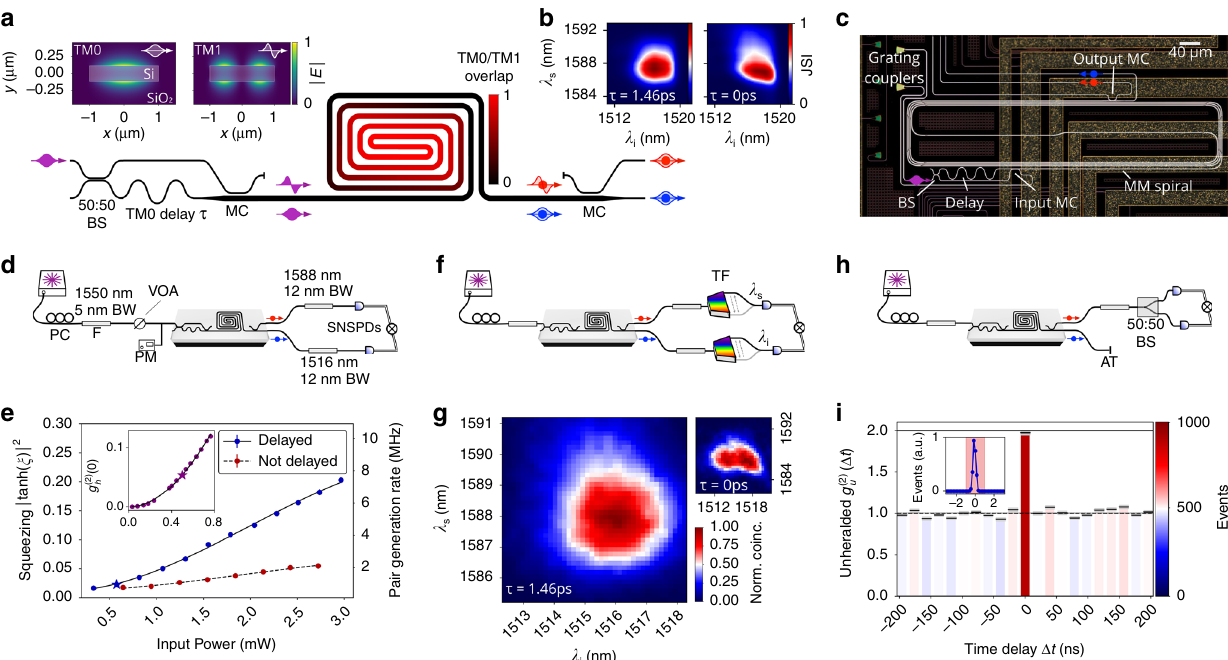
Fig. 1 Design and performance of the multi-modal source. a Schematic of the source. An input near-1550 nm pulsed pump laser (4.5 nm bandwidth), initially propagating in the TM0 mode, is split using a 50:50 beam-splitter (BS). The output in the upper arm of the BS is converted into the TM1 mode via a mode-converter (MC), while the TM0 output in the lower arm is delayed by a time τ = 1.46 ps. Due to the different group velocities, the two modes become overlapped and subsequently diverge again while propagating through the source, as qualitatively colour-coded in the fi gure. Photon pairs, with the signal photon (near 1588 nm) in the TM1 mode and the idler photon (near 1516 nm) in the TM0 mode, are emitted via inter-modal SFWM and fi nally deterministically separated via a MC. Inset: cross sections of the TM0 and TM1 modes in the MM waveguide. b Simulated JSI of the source in the presence of a delay τ = 1.46 ps (left) and with no delay (right), with corresponding single photon purities of 99.4% and 84.0%. c Optical microscope image of a single multi-modal source structure-waveguides are highlighted. d Set-up to characterise squeezed light via second-order correlation measurements, using a polarisation controller (PC), fi bre pass-band fi lter (F), variable optical attenuator (VOA), and an optical power monitor (PM). e Measured squeezing as a function of (off-chip) pump power. Blue and red points are data measured in a source with and without delay, respectively, with a fi t shown as a black ð 0 Þ as a function of input powers. f Set-up for the characterisation of line. The stars indicate the typical operating regime. Inset: measured heralded g ð 2 Þ h the emitted JSI, using a tunable fi lter (TF). g Measured JSI from the source with delay (left) and without delay (right), with respective corresponding spectral purities of 0.9904(6) and 0.931(2). h Set-up for purity characterisation via unheralded second-order correlation measurements. Idler photons are ð Δ t Þ in the source with delay. Each bar corresponds to a coincidence window of discarded via an absorbing termination (AT). i Measured unheralded g ð 2 Þ u ð 0 Þ ¼ 1 : 97 ð 3 Þ corresponds to a photon spectral purity of 0.97(3). Error bars represent 1 s.d. and are calculated assuming 2 ns (inset). The measured g ð 2 Þ u Poissonian error for the delayed structure is performed via unheralded second- 30 . These are implemented order correlation measurements g ð 2 Þ u by dividing the output signal mode with an off-chip balanced fi bre beam-splitter and measuring coincidences between the two output arms (see Fig. 1h). Measured unheralded second order-correlation values are reported in Fig. 1i. We obtain ð 0 Þ ¼ 1 : 97 ð 3 Þ , which corresponds to a single photon purity of g ð 2 Þ u 97(3)%, consistent with the value obtained from the JSI.